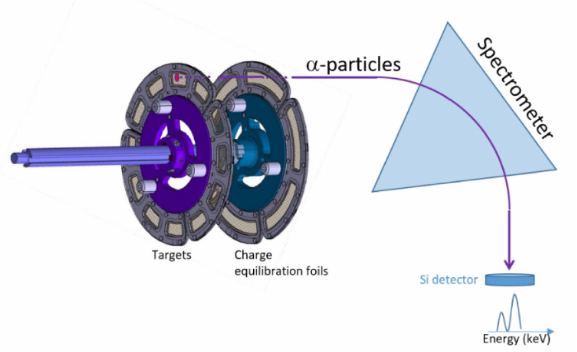
Fig. 3. Scheme of the a-activity method for active targets.